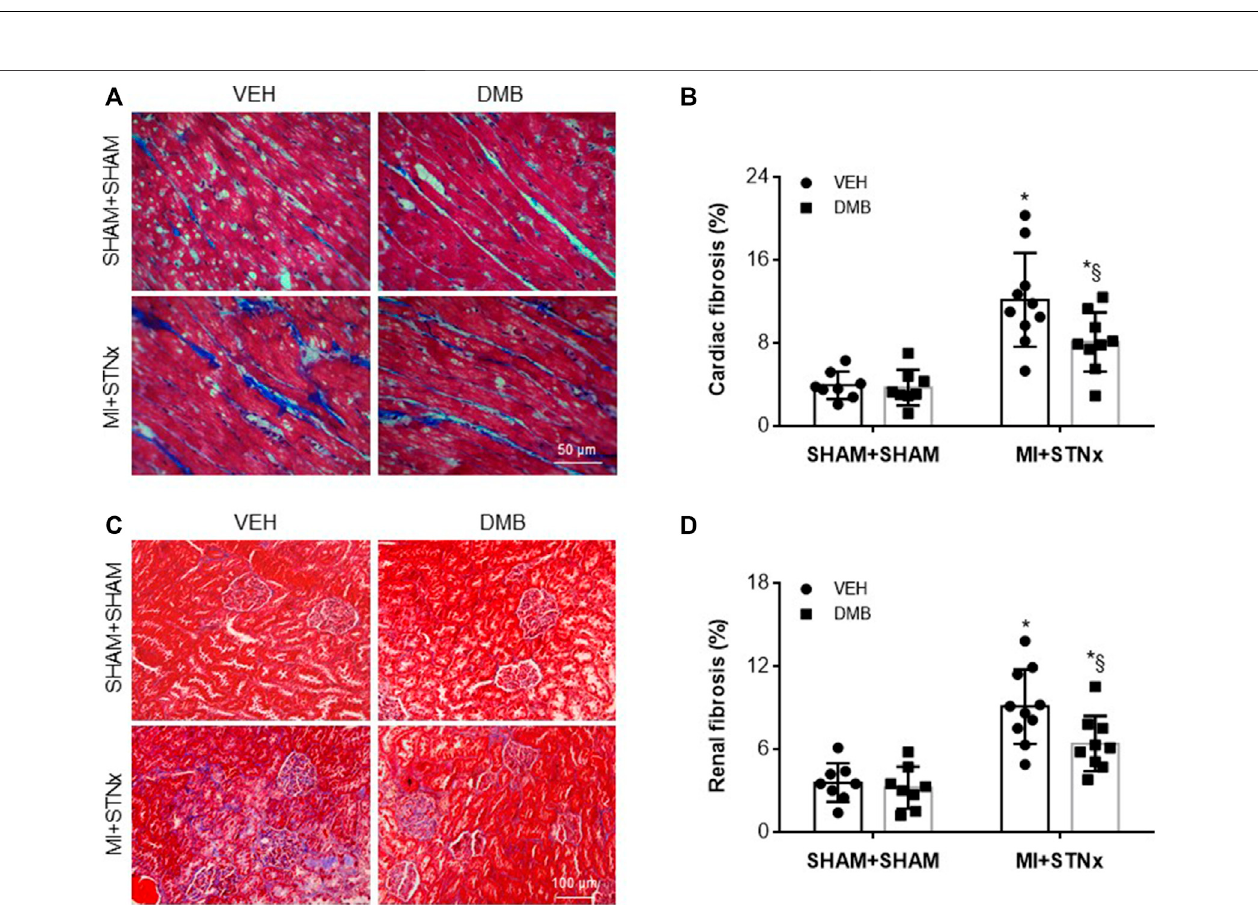
FIGURE 5 | Representative Masson Trichrome staining of the heart (A) and kidney (C) sections and effects of CRS2 and DMB treatment on cardiac (B) and renal fi brosis (D) . Data are expressed as mean ± SE ( n (cid:1) 8 – 10 for each group). * p < 0.05 vs SHAM + SHAM + VEH; § p < 0.05, MI + STNx + DMB vs MI + STNx + VEH.